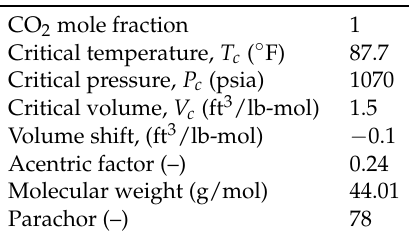
Figure 9. Radial model coupling the wellbore, the reservoir, and the aquifer, where the color map shows the depth. Table 2. Properties of the fluid.